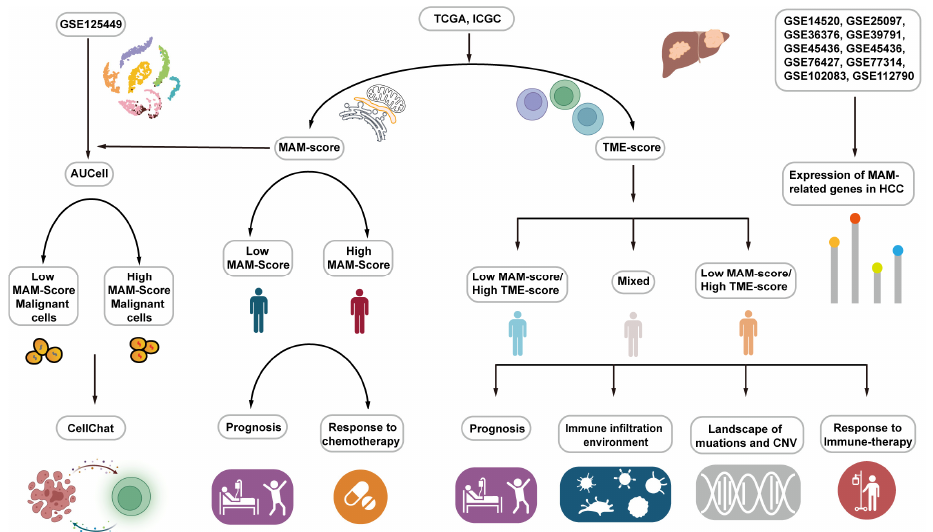
Figure 1. Overview of the workflow. HCC datasets (TCGA, ICGC, GSE14520, GSE25097, GSE36376, GSE39791, GSE45436, GSE54236, GSE76427, GSE77314, GSE102083, and GSE112790) were downloaded to demonstrate the differences in the MAM-associated genes between the normal and HCC groups. MAM score facilitated the prognosis as well as chemotherapy response. GSE125449 single-cell data were used to indicate